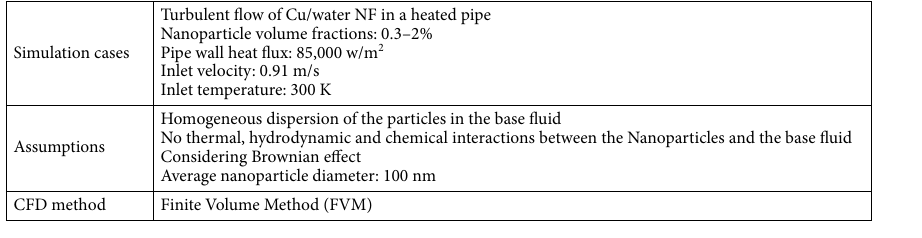
Table 3. CFD information